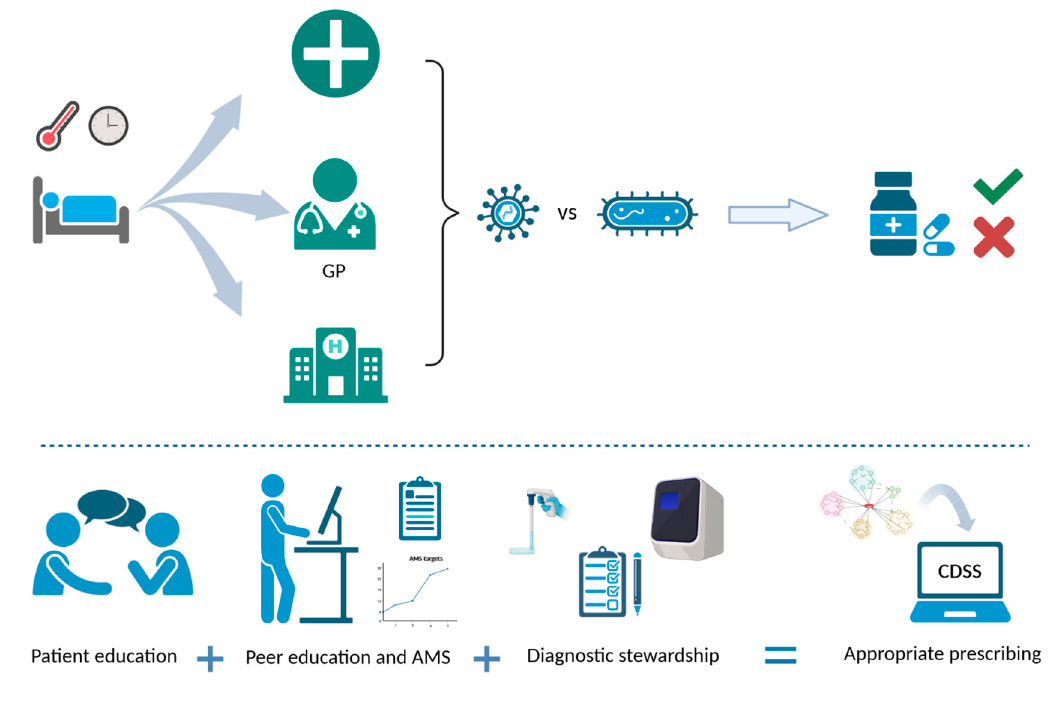
Figure 2. Opportunities for intervention to ensure appropriate antimicrobial prescribing practices throughout the continuum of care (created with BioRender.com). AMS = antimicrobial stewardship; CDSS = clinical decision support system.